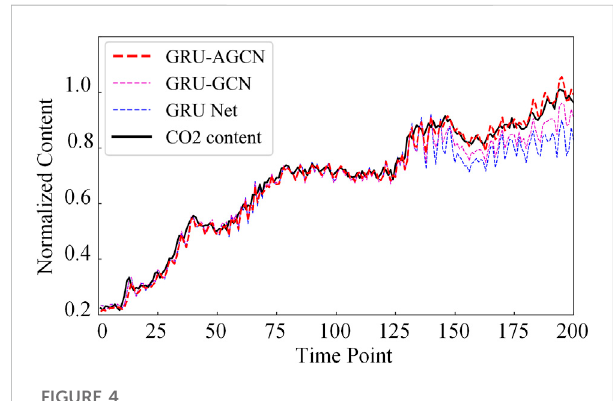
FIGURE 4 The effect of three models on CO 2 content